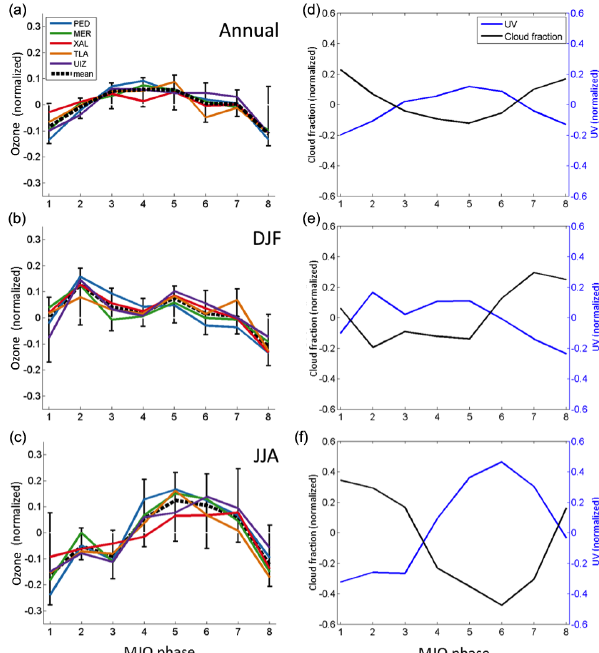
Figure 7. Mean standard anomalies of midday (hours 12:00– 16:00LT) surface ozone concentrations by active MJO phase for (a) annual, (b) DJF, and (c) JJA. Stations indicated by line color. Error bars indicate largest and smallest standard anomaly values for all stations; dashed black curve indicates mean value. All surface ozone observations from the RAMA network, 1986–2014. (d) Stan- dard anomalies of UV radiation (blue curves) and total cloud frac- tion (black curves) for each active MJO phase for the entire year. (e, f) Same as panel (d) but for DJF and JJA, respectively. UV and cloud fraction data from ERA-Interim reanalysis, 1986–2014, for the grid closest to Mexico